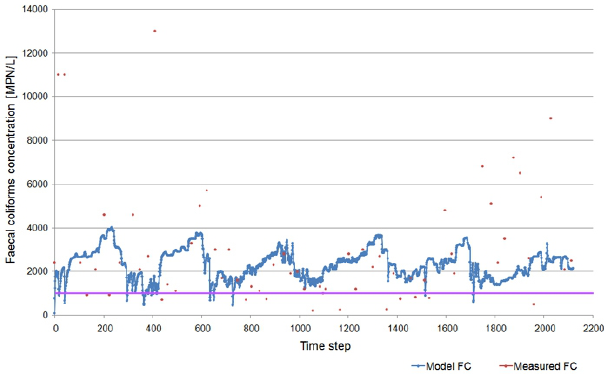
Fig. 5 . Example of a calibration plot for the ecological component of GUADEX (daily time step). The solid blue line represents modeled fecal coliform concentrations and individual points represent historical (measured) concentrations in the upper estuary. The solid pink line represents the fecal concentration